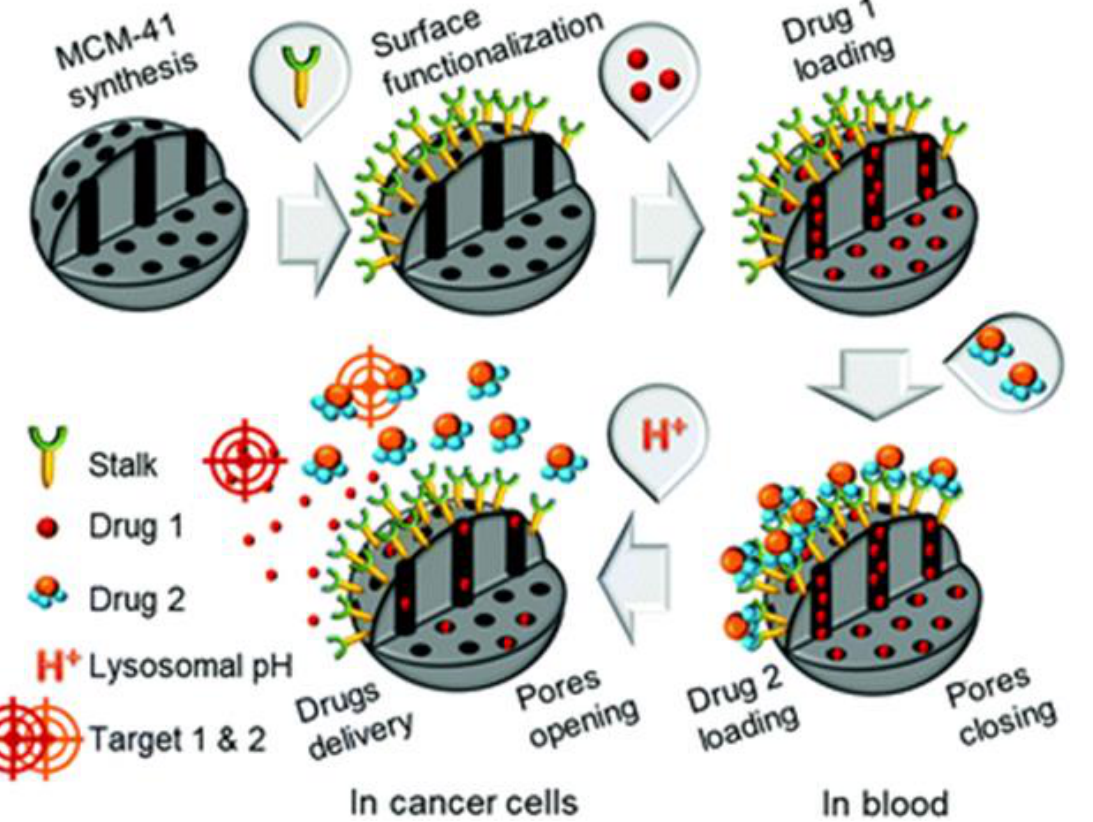
Figure 2. Schematic diagram of pH responsive mesoporous silica nanoparticle for the sequential delivery of CPT and 5-fluorouracil. The pores in the mesoporous silica nanoparticles (MCM-41) were loaded with CPT (Drug 1). Then, the pores were capped with 5-fluorouracil derivative (Drug 2) to prevent premature release at physiological pH through a stable H bond created with the Stalk located on the surface of the MCM-41. At acidic pH, the protonation of Stalk triggers the release of 5-fluorouracil followed by the release of CPT through disruption of Stalk-cap bonds. Reproduced from [141] with permission from The Royal Society of